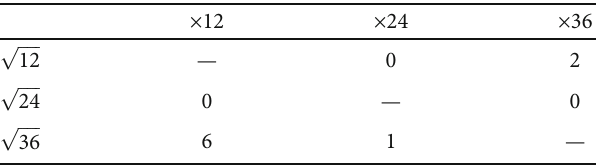
Table 10: Classi fi cation accuracy of the experimental periods in the well data-accumulated areas.